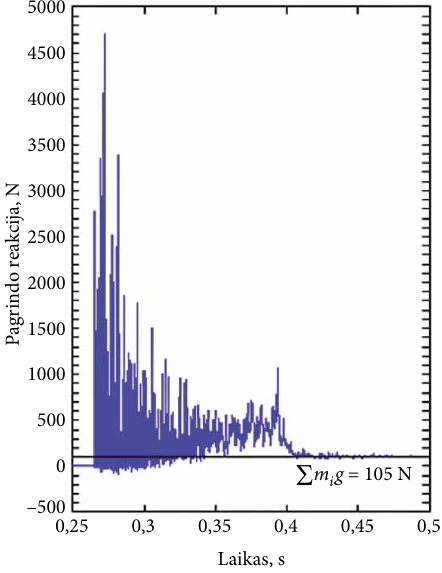
Fig. 7. Reaction balance between between the basis of the computational space of polydspersed